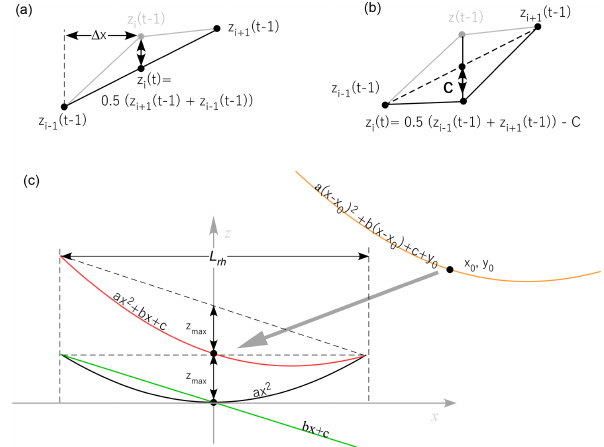
Figure 2. Principle of the calculation of the SLBL. (a) The iterative calculation replaces t at each step with the value of the average of its two neighbours with index z ( t − 1) > ( z i − 1 ( t − 1) + z i + 1 ( t − 1)) / 2. (b) Similar to (a) , but for a condition of z ( t − 1) > ( z i − 1 ( t − 1) + z i + 1 ( t − 1)) / 2 – C. (c) Diagram explaining why z max is dependent on only a and not on the linear part of the expression ( bx + c